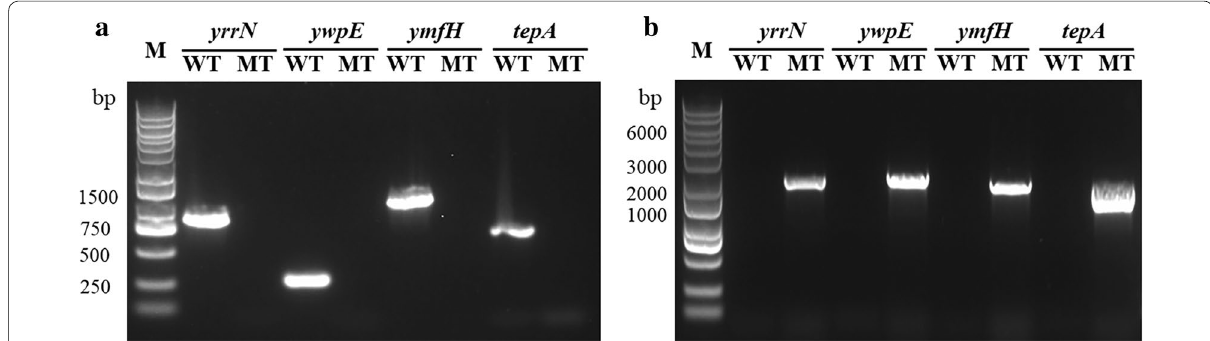
Fig. 1 Confirmation of the disruptions of yrrN , ywpE , ymfH and tepA . PCR products were amplified from the genomes of wild ‐ type (lane WT) and mutant (lane MT) strains using verification primer pairs as described in “Materials and methods” section. Lane M: DNA marker (M115,